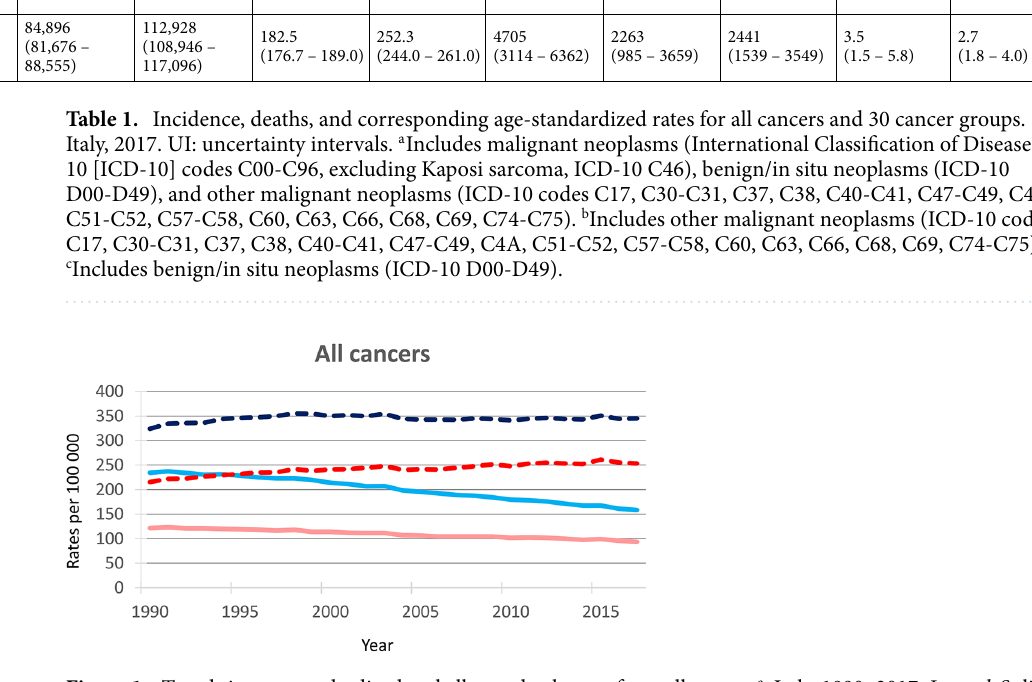
Figure 1. Trends in age-standardized and all ages death rates from all cancers a , Italy, 1990–2017. Legend: Solid lines show age-standardized death rates for men (light blue) and women (light red), dashed lines show all ages death rates for men (blue) and women (red). a Includes malignant neoplasms (International Classification